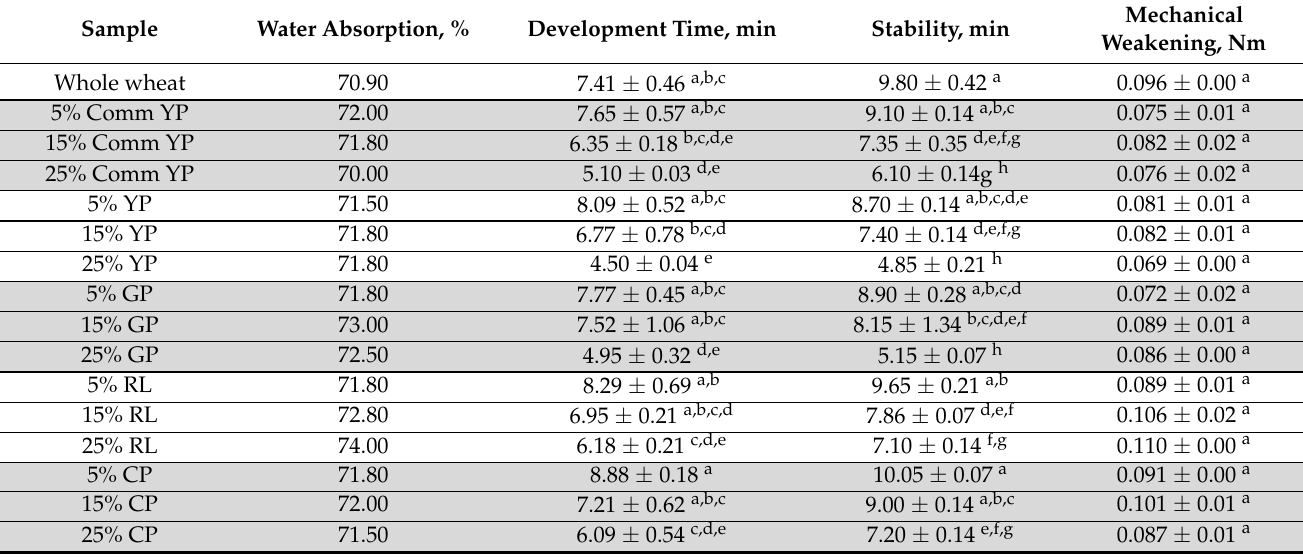
Table 2. Mixing characteristics of whole wheat/pulse flour blend from Mixolab.